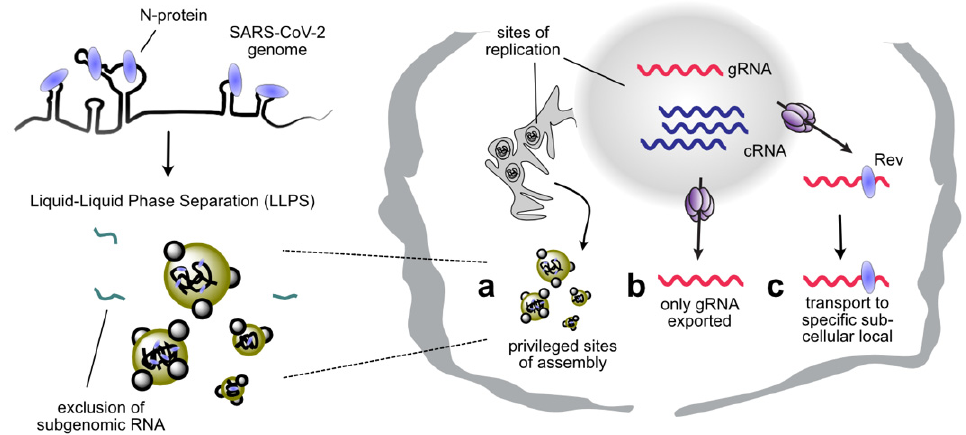
Figure 3. Successful genome packaging requires RNA signals to direct the genome from sites of replication to sites of assembly. ( a ) Sites of assembly generated by liquid-liquid phase separation (LLPS). Specific interactions between the SARS Coronavirus-2 (SARS-CoV-2) nucleoprotein (N) and its genome induce LLPS. Sub-genomic RNA is excluded. ( b ) Influenza complementary RNA (cRNA) replication intermediates are not correctly exported from the nucleus and are therefore not